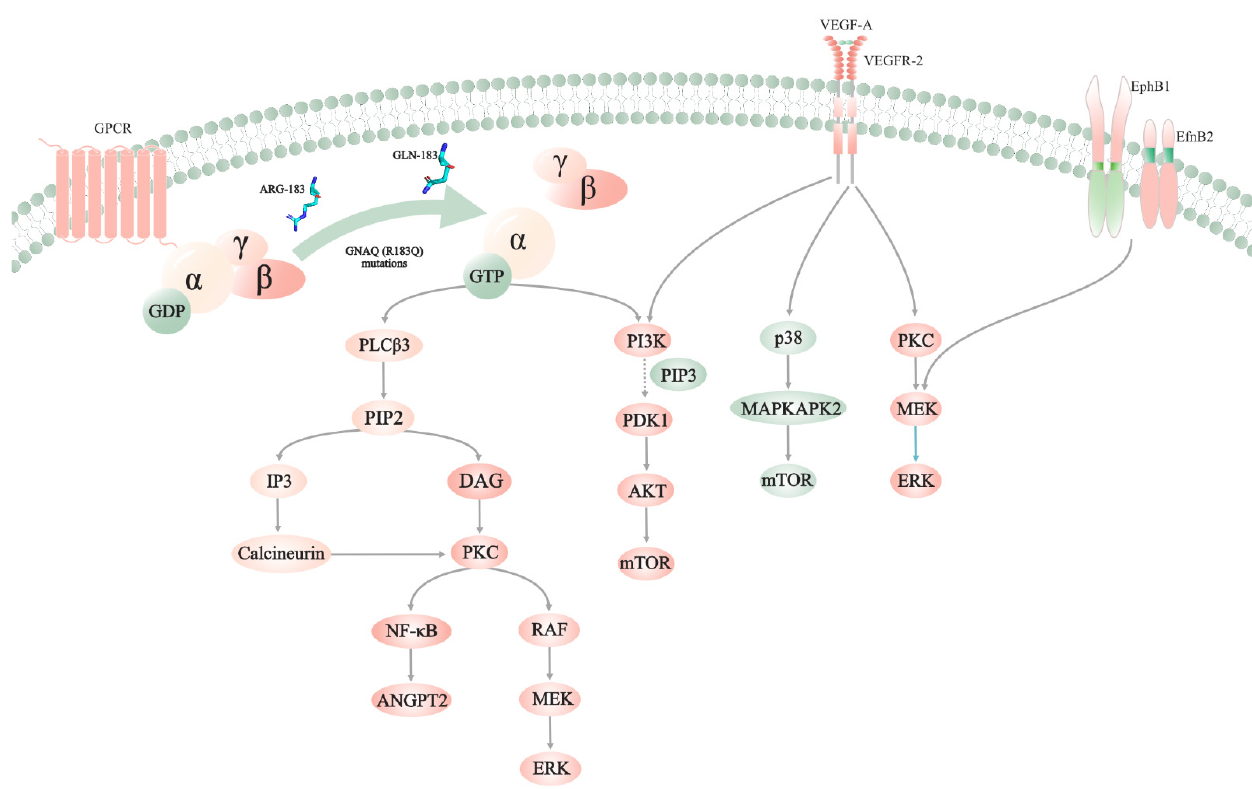
Figure 1. The potential pathogenesis of PWSs. GNAQ (R183Q) mutations activate classic MAPK, PKC/NF- κ B/ANGPT2, and PI3K/AKT/mTOR pathways. Meanwhile, overexpression of VEGF-A